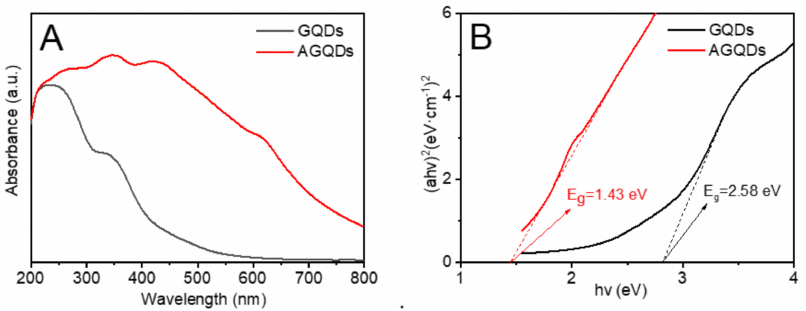
Figure 3. ( A ) UV—Vis spectra, ( B ) corresponding ( ahv ) 2 versus h v plots of GQDs and